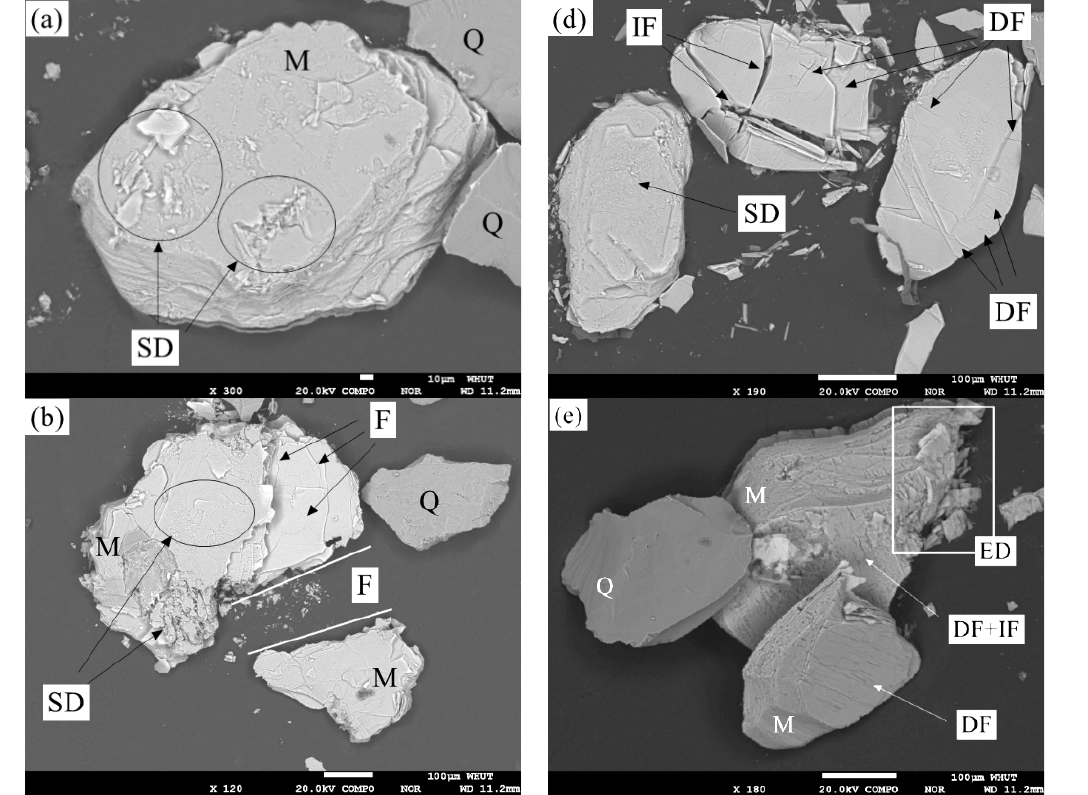
Figure 2. Optical morphology of muscovite within leached quartz sand: (1) 0.025 mol/L H 2 SO 4 , 0.050 mol/L NH 4 Cl ( a ) − 150 °C; ( b ) − 200 °C; ( c ) − 250 °C; (2) 0.050 mol/L H 2 SO 4 , 0.100 mol/L NH 4 Cl ( d ) − 150 °C; ( e ) − 200 °C; and ( f ) − 250 °C; DF—directional fracture, IF—interlaced fracture. G—“gulf”; the scale bars are the